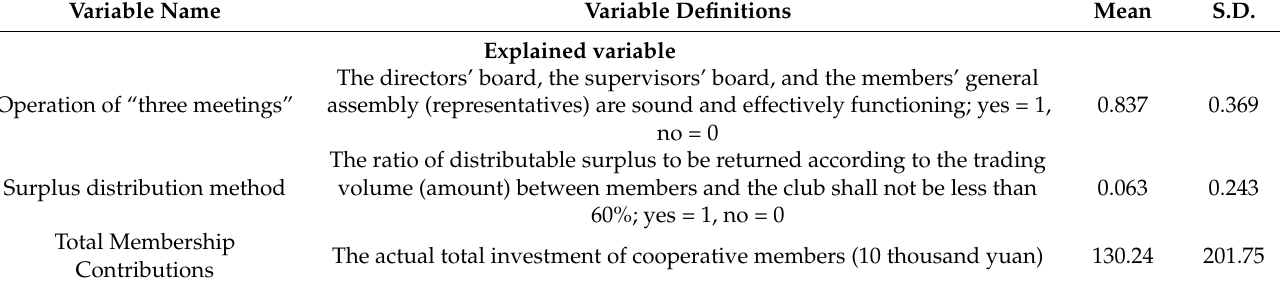
Table 3. Variable definitions and descriptive